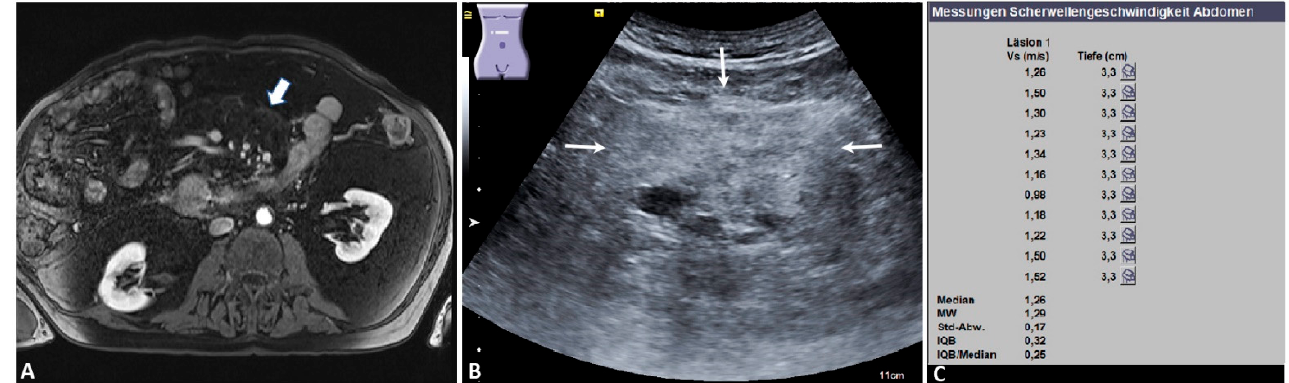
Figure 1. Benign mesenteric mass. An 80-year-old male patient with a known history of type 1 autoimmune pancreatitis under immunosuppressive treatment. ( A ) Magnetic resonance imaging appearance of a mass-like “misty mesentery” in the right upper portion of the umbilical region (arrow) (courtesy of Prof. Dr. Mahnken, Department of Radiology, University Hospital Marburg); ( B ) the ultrasound appearance of an ill-defined, slightly inhomogeneous, echogenic mesenteric mass (arrows); ( C ) the final acoustic radiation force impulse (ARFI) report of the same mass, showing a mean ARFI velocity (MW) of 1.29 m/s. The mesenteric histology showed an IgG − 4-positive sclerosing mesenteritis. Läsion 1: lesion 1; Vs (m/s): velocity in meter per second; Tiefe (cm): depth in centimeter; MW = mean value (Mittelwert); Std-Abw.: standard deviation (Standard Abweichung); IQB: interquartile range (Interquartilbereich).